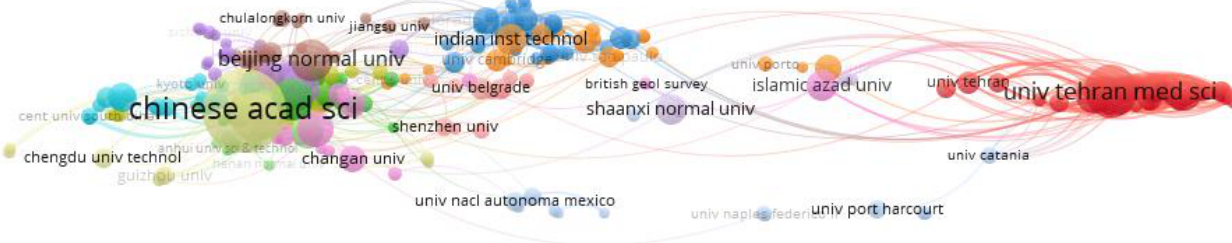
Figure 4. Cooperation between countries.